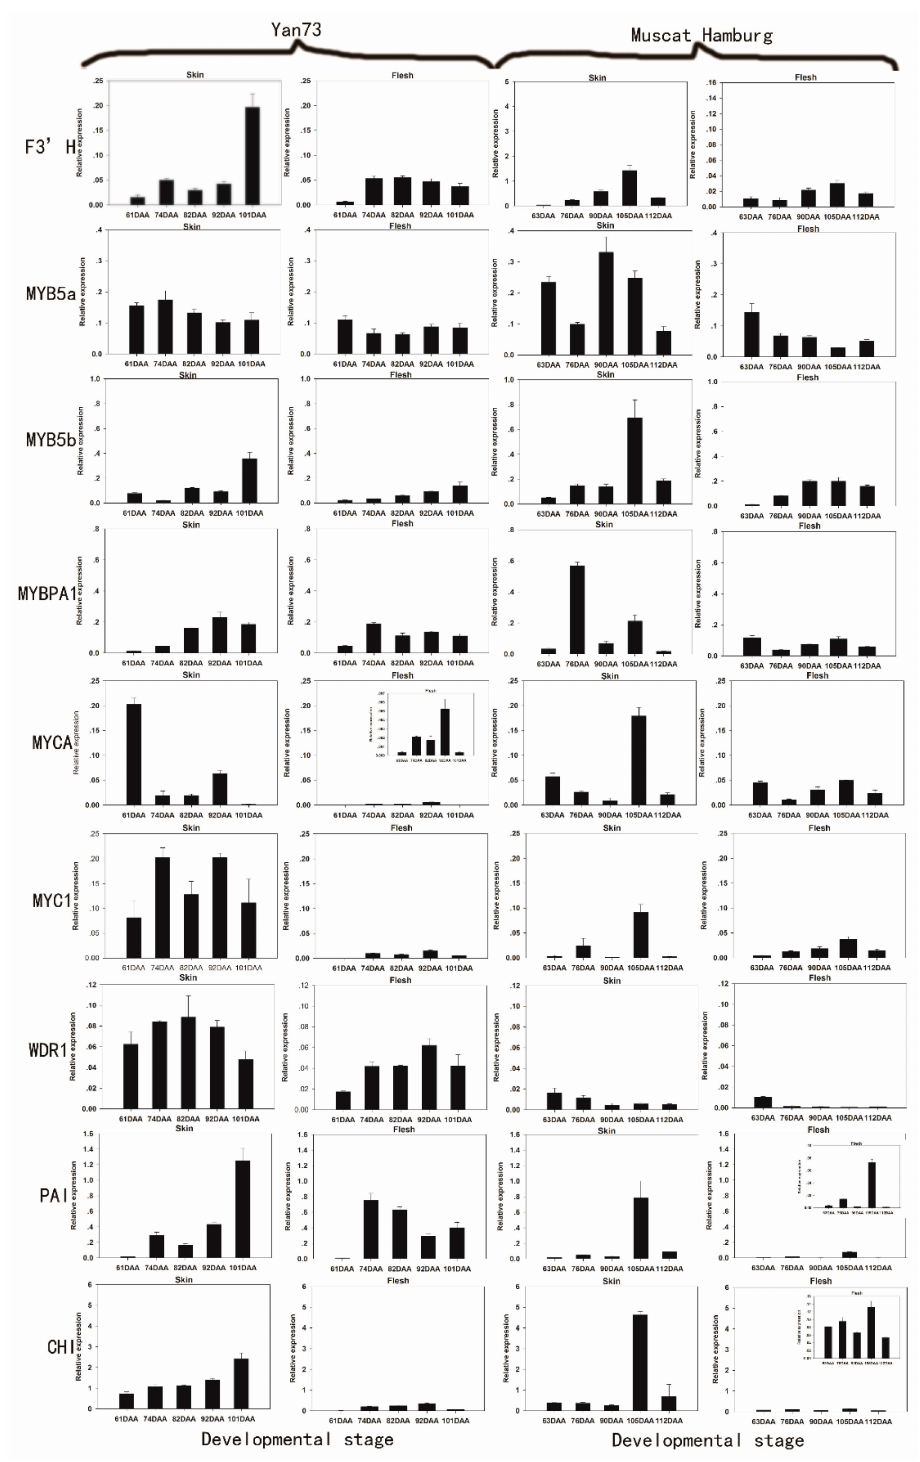
Figure 2. Expression patterns of anthocyanin biosynthetic genes in the skin and flesh of Yan 73 and Muscat Hamburg cultivars across five developmental stages. The data are derived from qPCR analysis and are normalized to VvUbiquitin . The transcriptional levels of the same gene in the skin and flesh tissues of Yan 73 and Muscat Hamburg are expressed on the y axes with the same scale, and relatively lower values are magnified in inset graphs with y axes with narrower scales. Berry developmental stage is referred to on the x axis. DAA, days after anthesis; 61 DAA (63 DAA) pre-véraison; 74 DAA (76 DAA), 50% véraison green; 82 DAA (90 DAA), 50% véraison red; 92 DAA (105 DAA), 100% véraison; 101 DAA (112 DAA), harvest. Error bars illustrate the standard errors for three replicates.